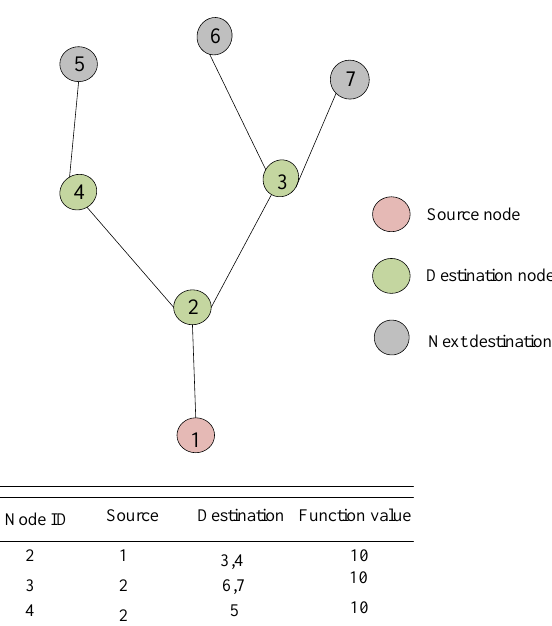
Figure 4. Source and destination with optimal relay table.